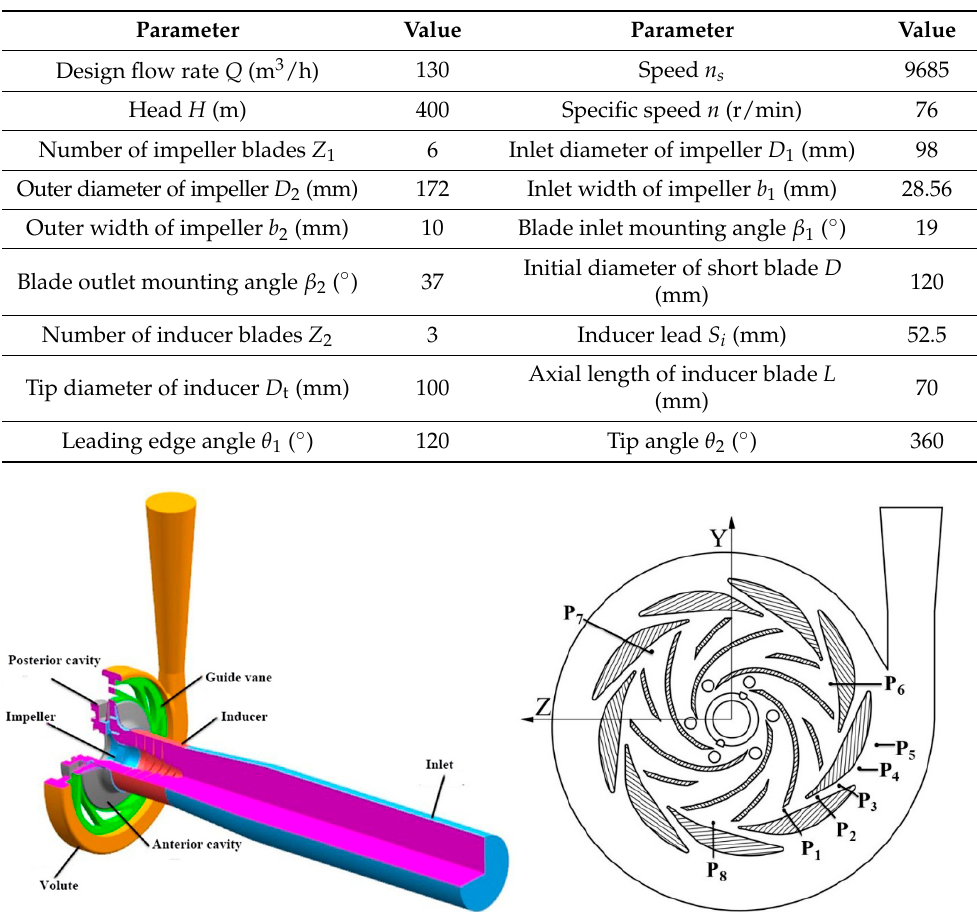
Table 1. Parameters of the high-speed centrifugal pump.